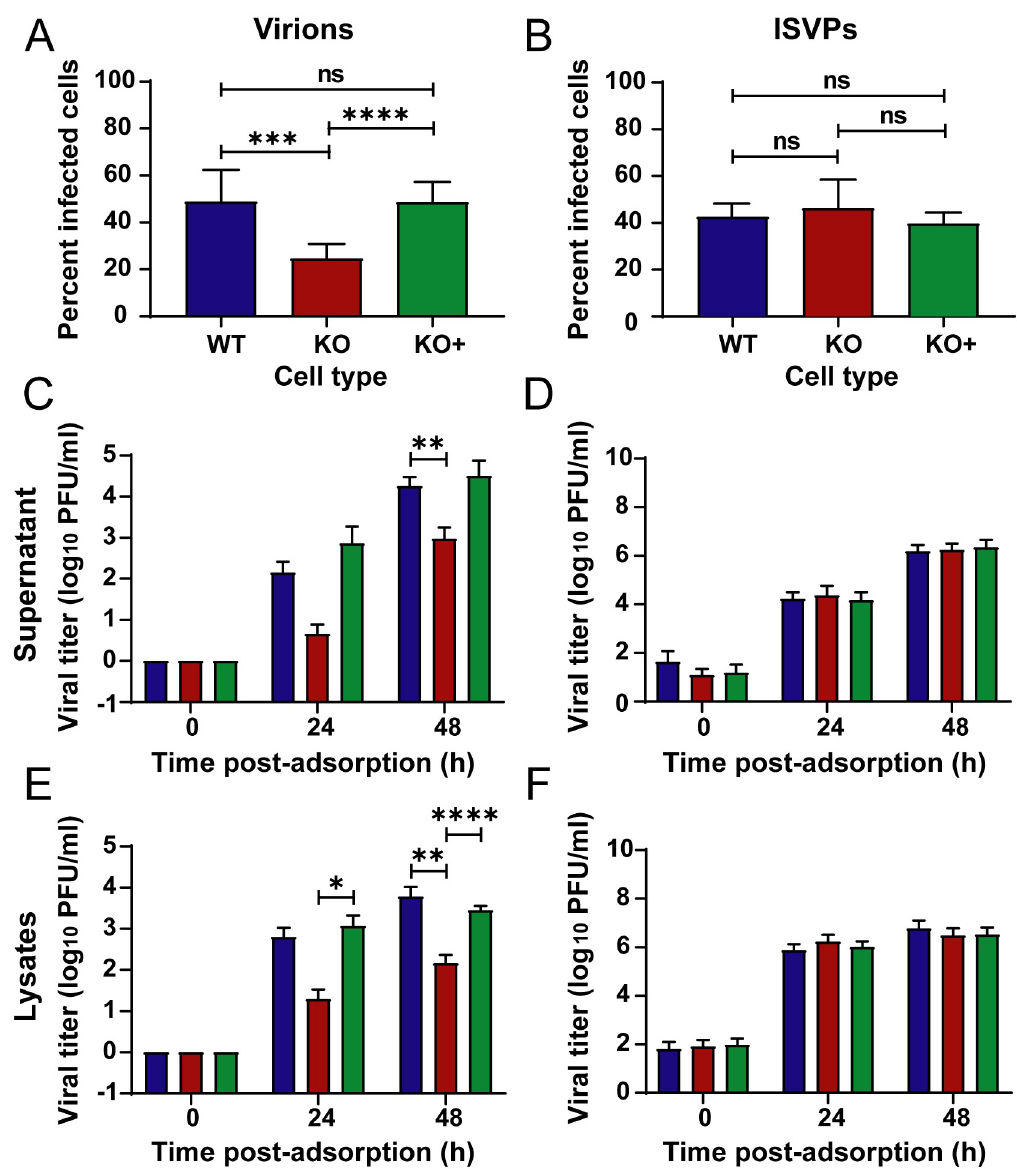
Fig 2. Viral infectivity and titers following adsorption by reovirus virions and ISVPs. (A, B) WT, KO, and KO+ HBMECs were adsorbed with reovirus (A) virions or (B) ISVPs at MOIs of 10,000 or 100 particles/cell, respectively, and fixed at 18 h post-adsorption. The percentage of infected cells was determined by enumerating reovirus-infected cells following immunostaining with a reovirus-specific antiserum. (C-F) WT, KO, and KO+ cells were adsorbed with reovirus (C, E) virions at an MOI of 1 PFU/cell or (D, F) ISVPs at an MOI of 5 particles/cell. Viral titers in cell-culture supernatants and lysates were determined by plaque assay at 0, 24, and 48 h post-adsorption. The results are presented as the mean of three independent experiments. Error bars indicated standard deviation. � , P < 0.05; �� , P < 0.01; ��� , P < 0.001; ���� , P < 0.0001, as determined by t-test.